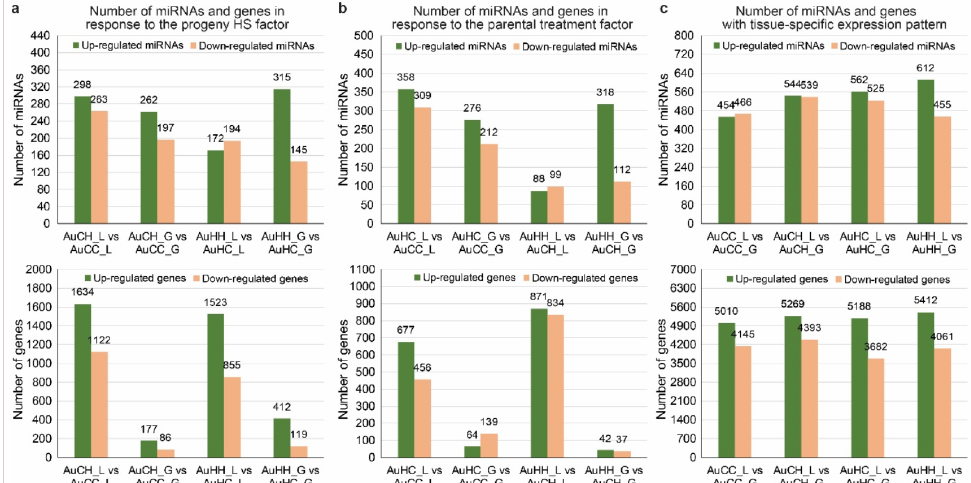
Figure 3. The number of up-regulated and down-regulated miRNAs and genes subject to different factors: ( a ) progeny heat stress treatment, ( b ) parental heat stress treatment, ( c ) tissue type. The treatment groups are: AuCC (DBA Aurora progeny treated with the control, originated from control group parents), AuCH (DBA Aurora progeny treated with heat stress, originated from control group parents), AuHC (DBA Aurora progeny treated with the control, originated from heat stress group parents), AuHH (DBA Aurora progeny treated with heat stress, originated from heat stress group parents). _L indicates flag leaf library and _G indicates developing grains